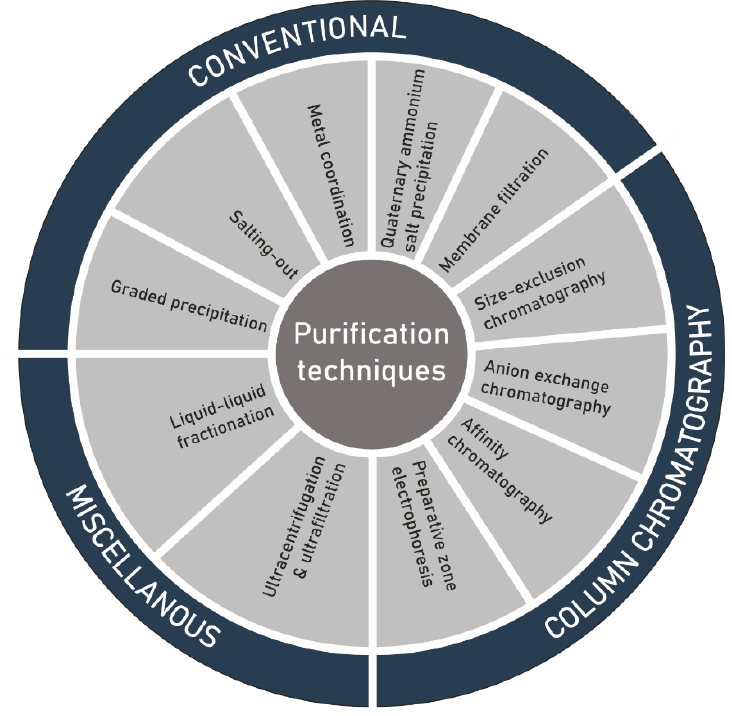
Figure 3. Techniques for the purification of polysaccharide sulfates extracted from seaweed.